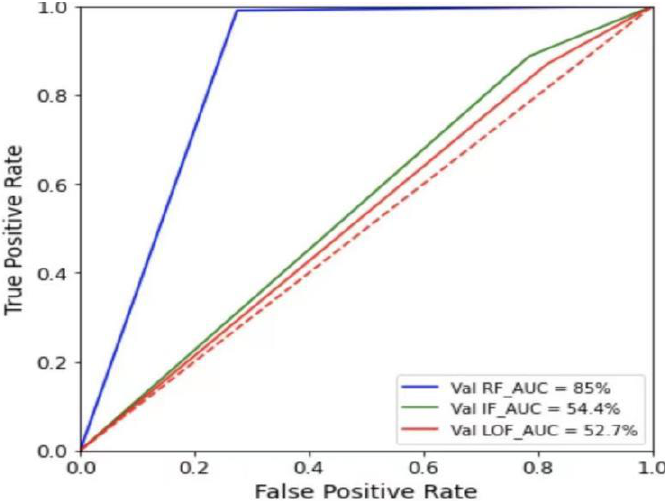
Figure 5. ROC curve of binary classification experiments.